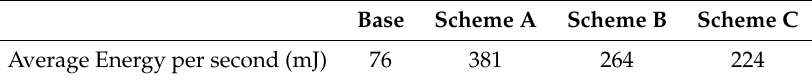
Table 7. Average energy per second of each scheme